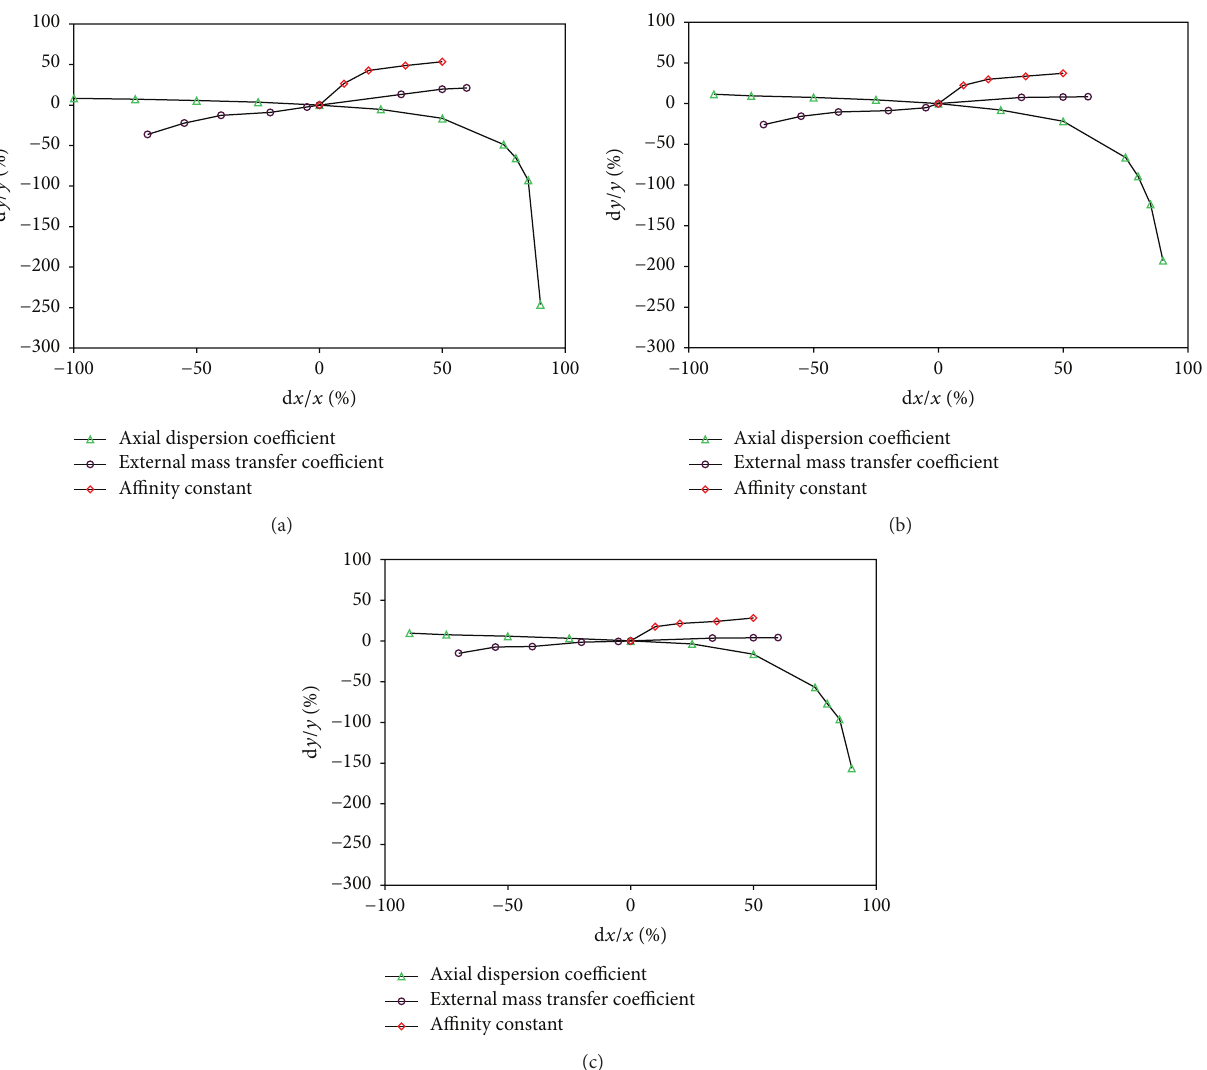
Figure 9: Sensitivity analysis of the mass transfer model for the adsorption of (a) Cd 2+ , (b) Cu 2+ , and (c) Pb 2+ onto